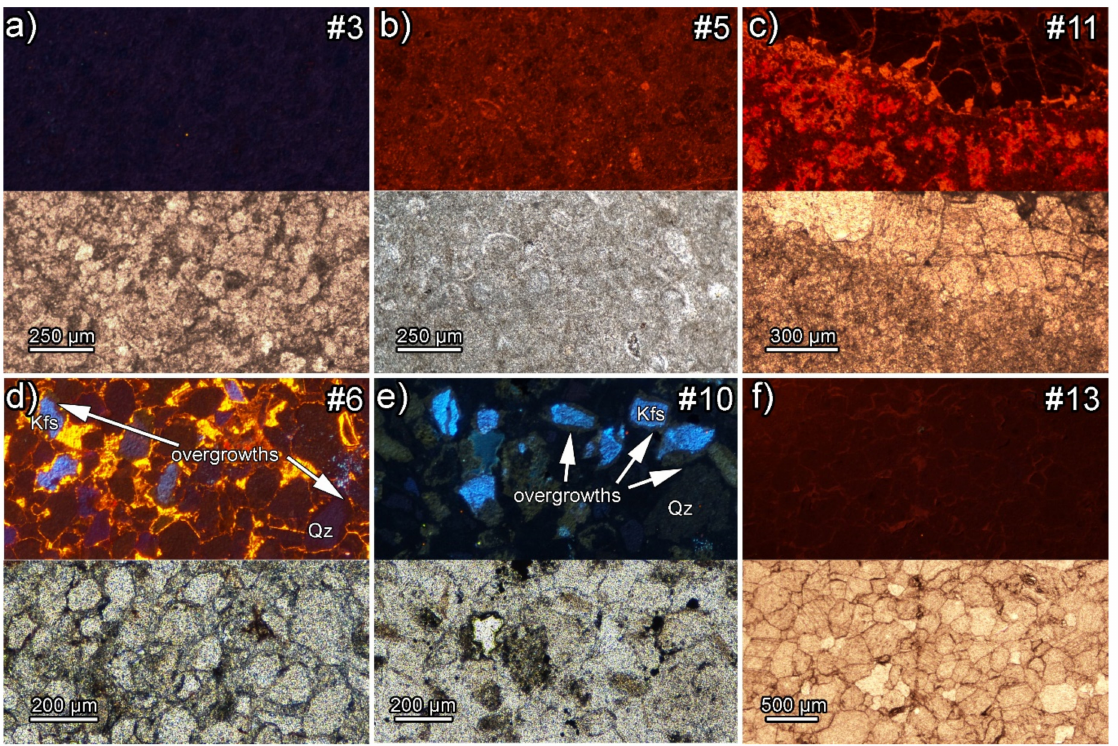
Figure 4. Petrographic images of thin sections of some sampled stone tesserae from the Circus mosaic including the same areas viewed under CL ( top ) and PPL ( bottom ): ( a ) #3 limestone; ( b ) #5 limestone; ( c ) #11 limestone; ( d ) #6 and ( e ) #10 sandstones showing authigenic overgrowths on quartz (Qz) and K-felspar (Kfs) grains; ( f ) marble